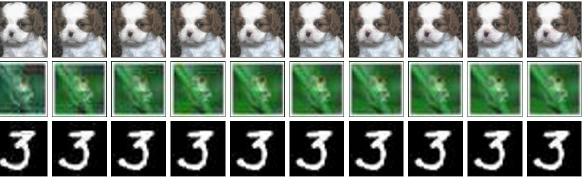
Figure 2. JPEG compression examples, sorted from left to right by quality value, ranging from 10 to 100 (original image). ( Top ) images: from ImageNet, ( middle ): CIFAR10, and ( bottom ): MNIST.